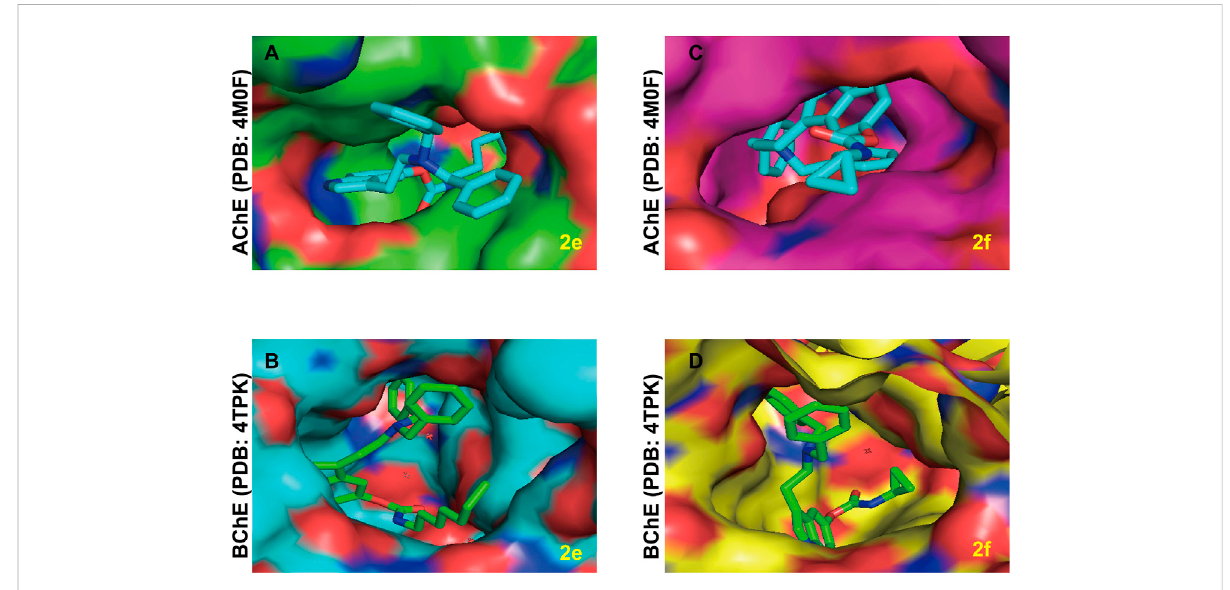
FIGURE 7 The possible binding mode for the compounds 2e and 2f in the AChE (PDB code: 4M0F) and BuChE (PDB code: 4TPK) binding sites. (A,B) The potential distribution surface diagrams of 2e in AChE and BuChE binding sites , respectively, created by Pymol (http://www.pymol.org). (C,D) The potential distribution surface diagrams of 2f in AChE and BuChE binding sites , respectively, created by Pymol